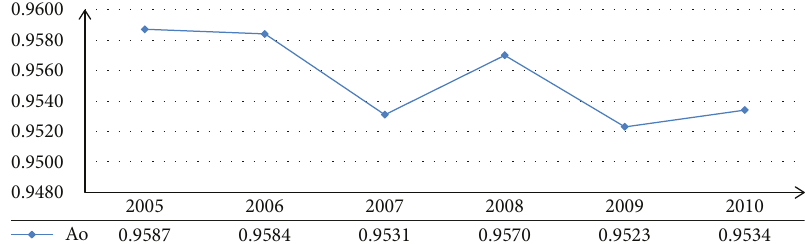
Figure 6: Characteristic form of operational availability function for period II.